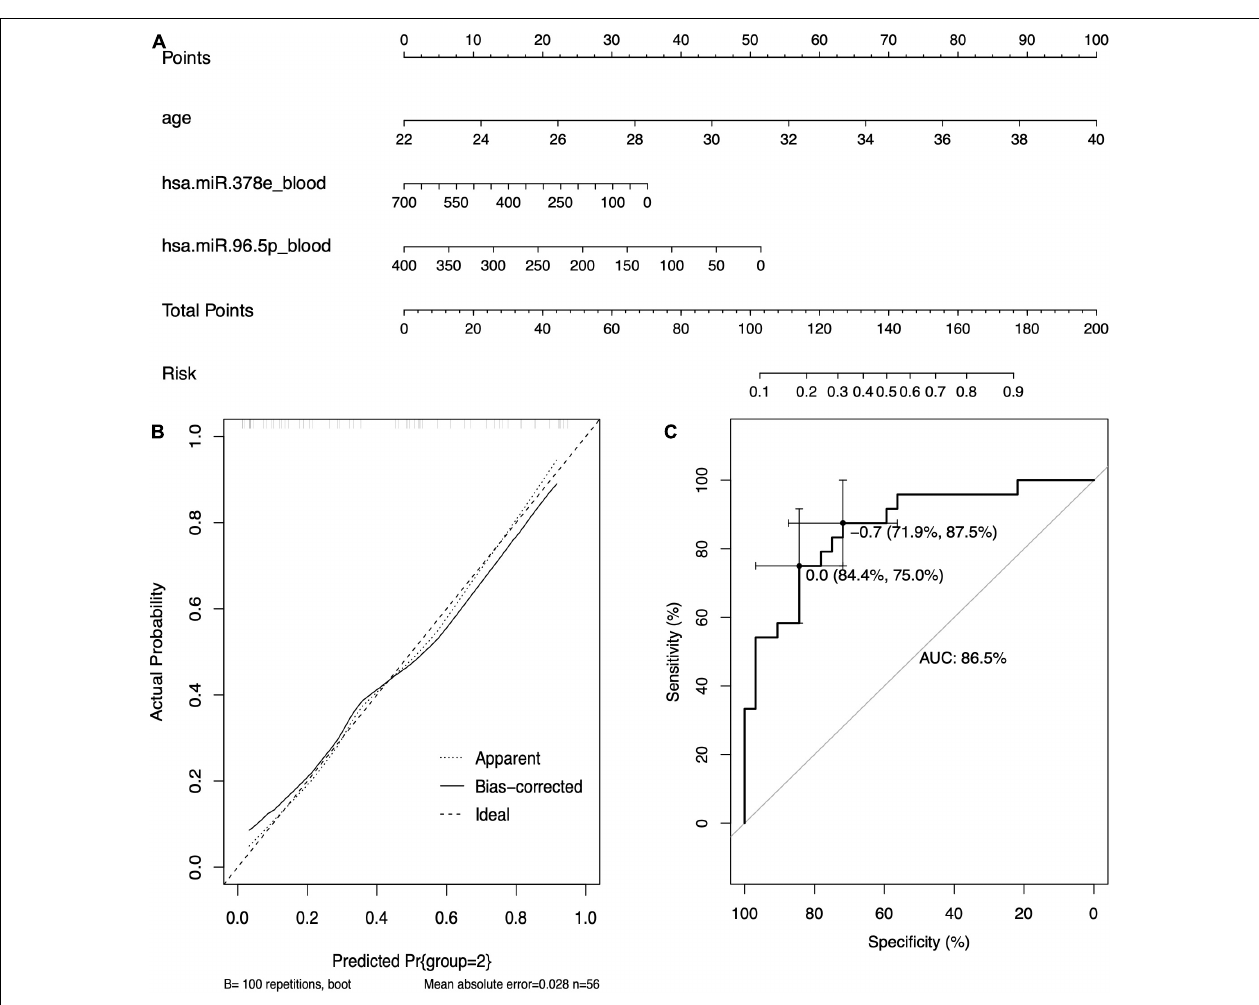
FIGURE 6 | The prediction model based on circulating miRNAs. (A) The nomogram of the prediction models based on circulating miRNAs. (B) The calibration curves of the prediction model. (C) The receiver operating characteristic (ROC) curve of the prediction model.